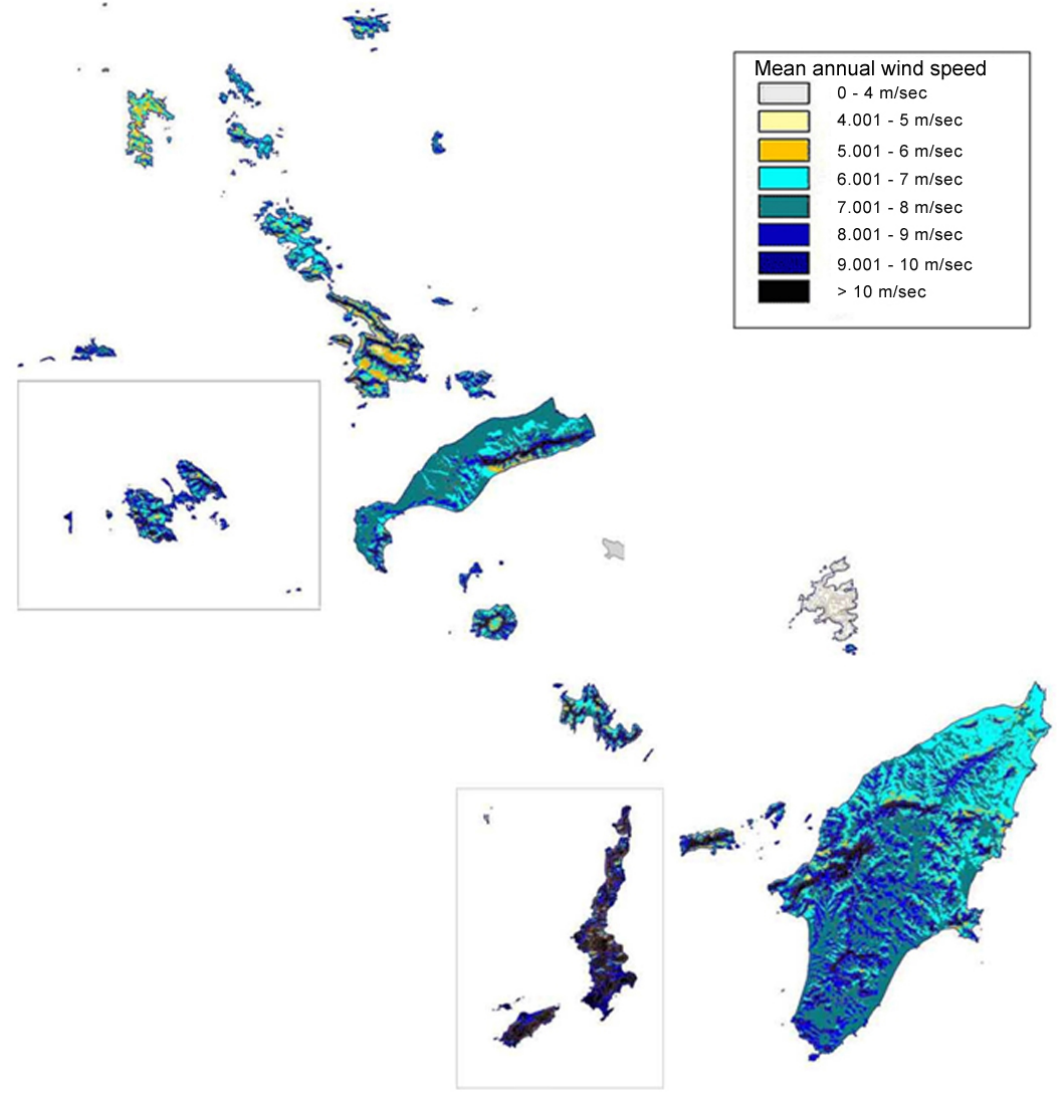
Figure 7. Thematic map for the estimation of the technically and economically exploitable potential of wind energy in the Dodecanese islands [59].